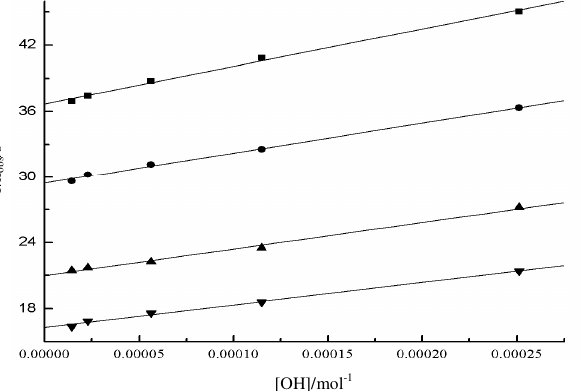
Figure 4 . Plots of 1/ k versus [OH - ] at different temperatures (r ≥ 0.997) [Fe(VI)] = obs 1.04 × 10 -4 mol·L -1 , [Triethanolamine] = 0.40 mol·L -1 , I = 1.00 mol·L